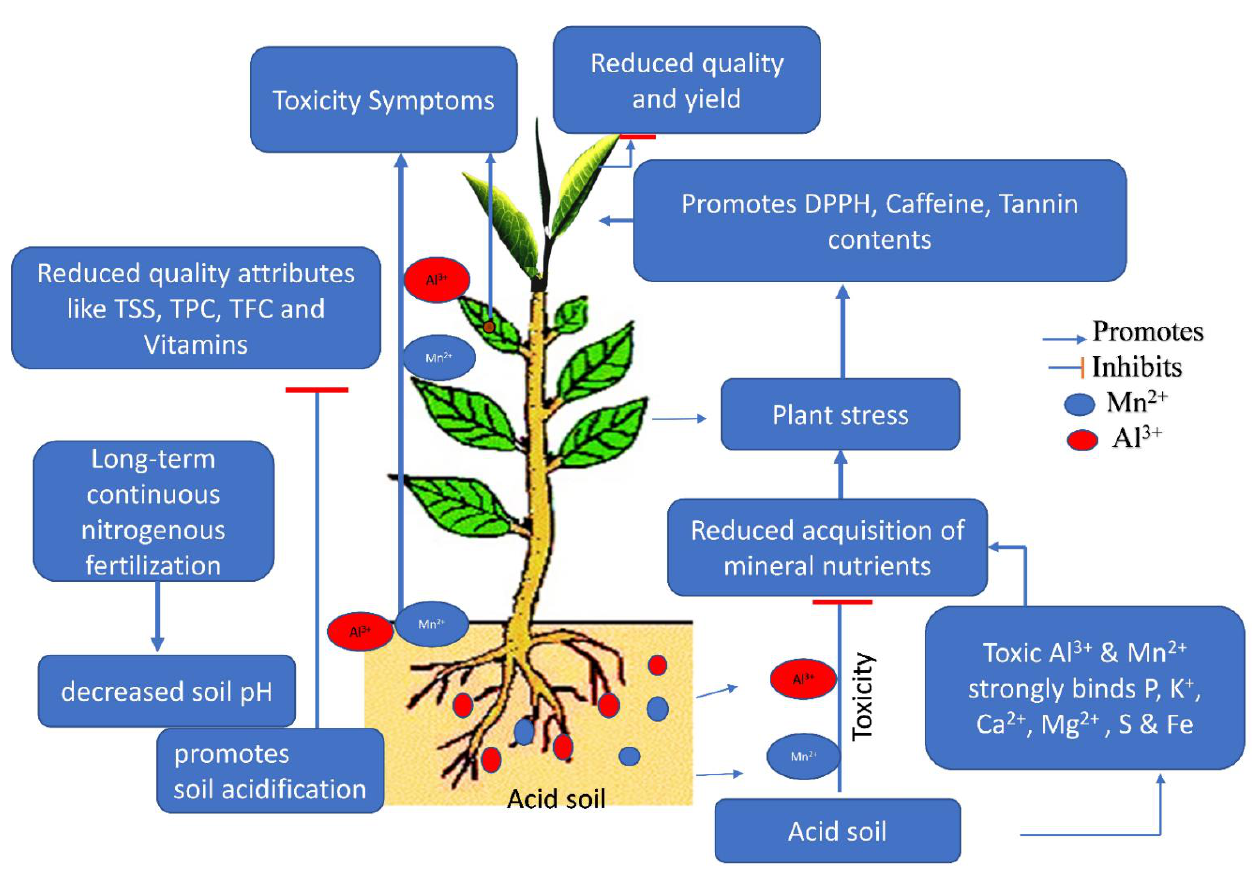
Figure 6. Schematic representation of the effects of long-term traditional fertilization on tea garden soil and tea leaf quality.